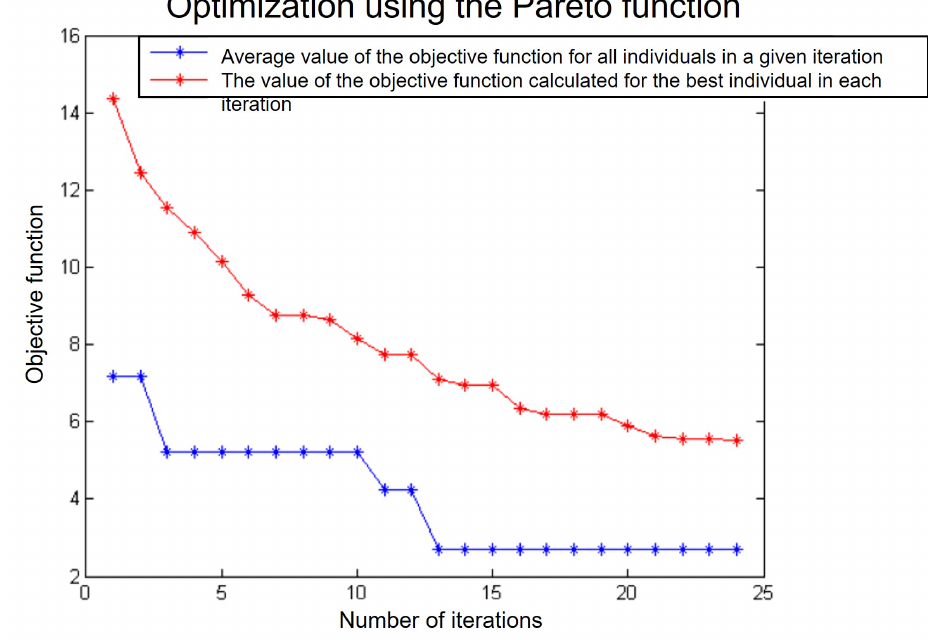
Figure 13. Optimization using the Pareto